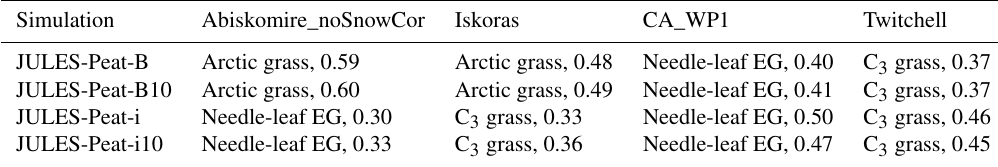
Table 5. Dominant vegetation type and fraction at the end of the spin-up for the sites and runs shown in Fig. 11. EG stands for evergreen.